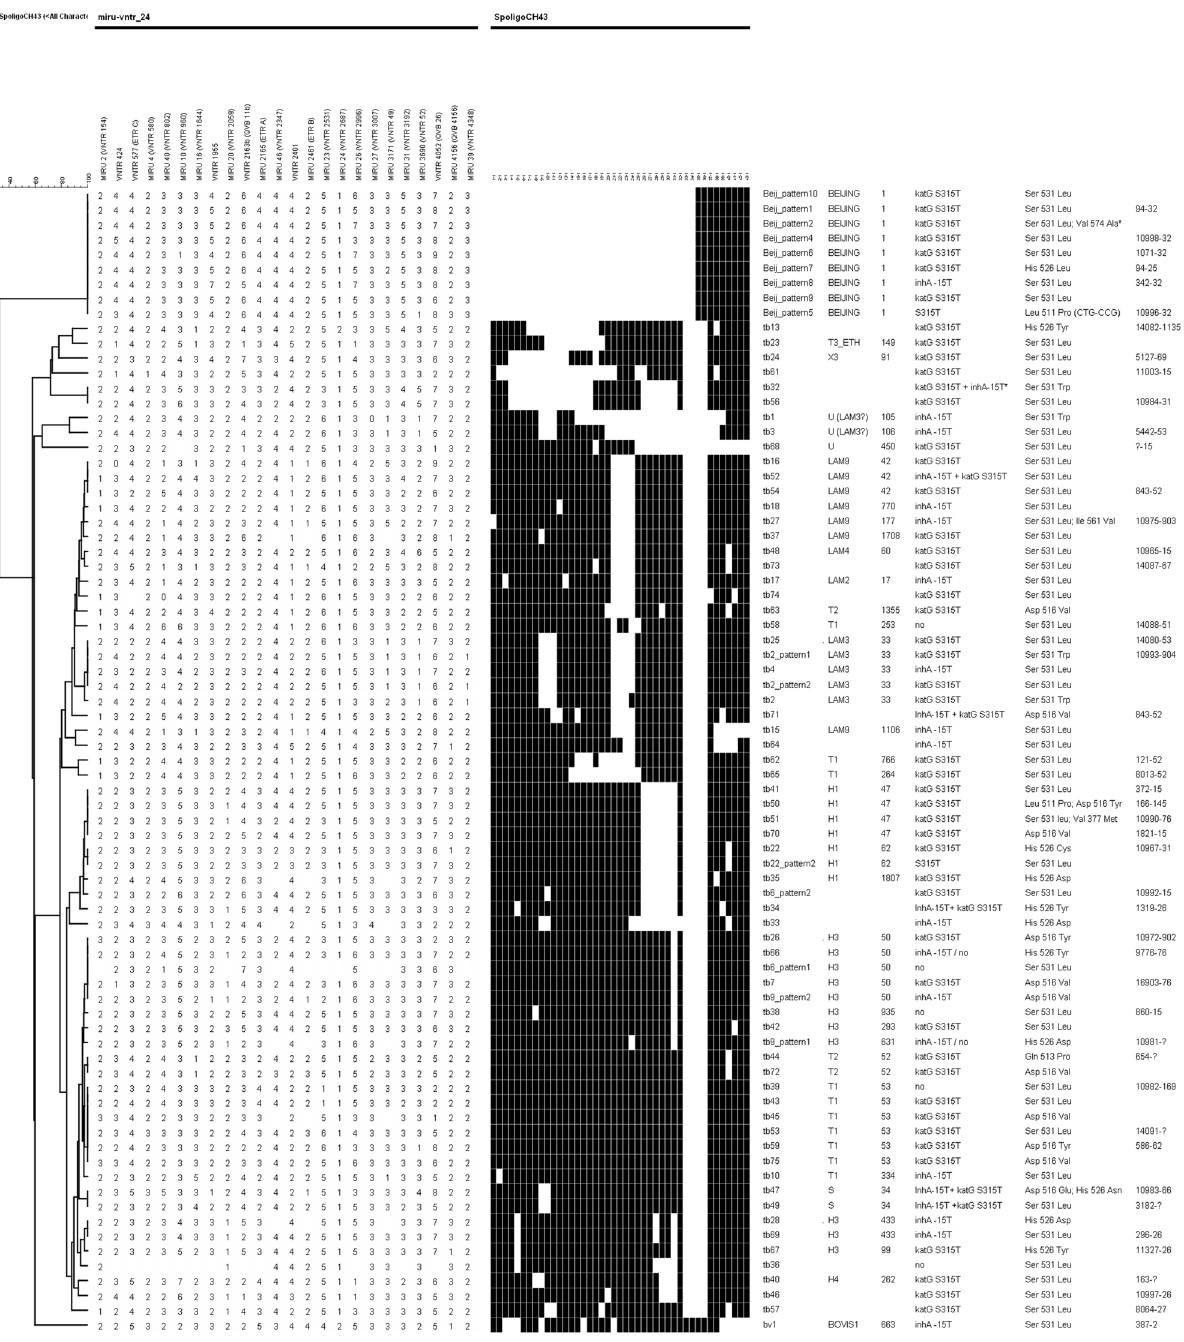
gender-ratio M/F was 1.9:1. The age was available for 76.5% (n = 604) with a non-homogenous distribution, with the highest proportion of diagnoses occurring in individuals aged 15–34 years (41.5%). The overall mean age was